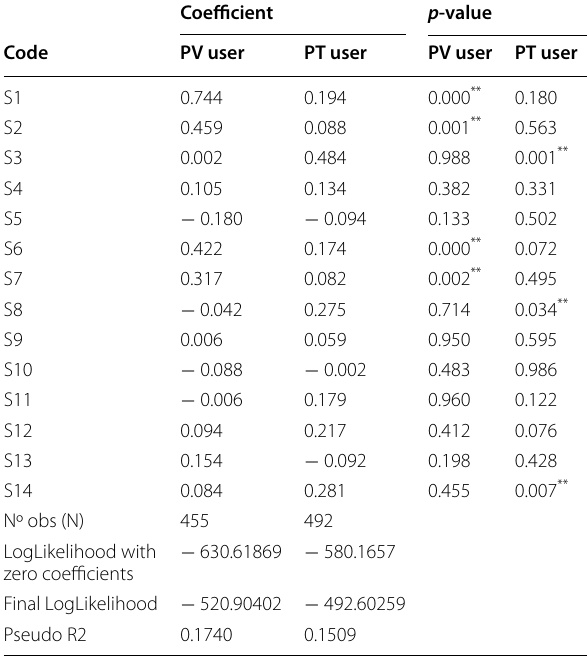
Table 5 The results of the OLM for the respondents’ satisfaction of PT and PV